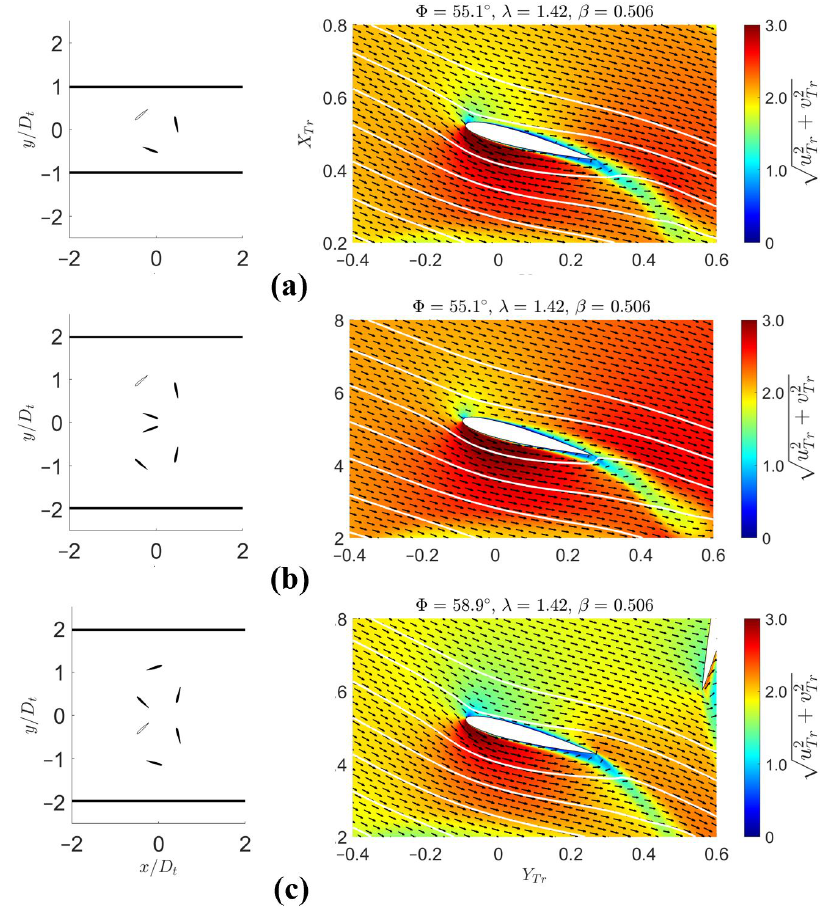
Figure 25. The velocity fields in the blade reference frame before it reached the maximum torque of the 3 configurations: single turbine ( a ), forward counter-rotating turbines ( b ), and backward counter-rotating turbines ( c ). On each figure, the lower surface is the turbine inner side and the upper surface is the turbine outer side. The figures on the left side show the position of the blade of interest colored in